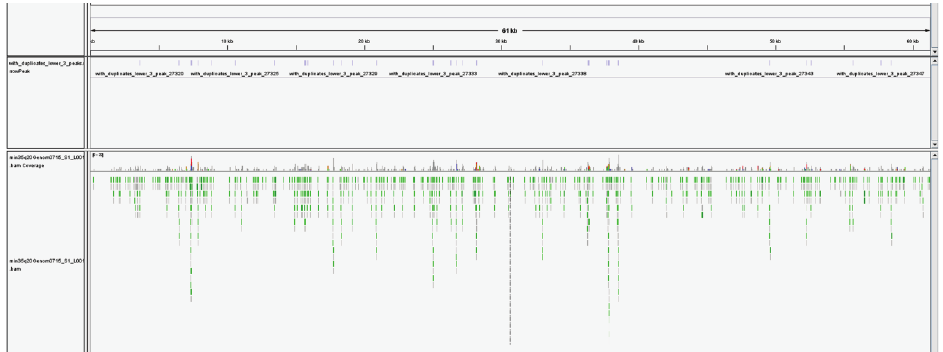
Figure 4. A representative region of the of assembled D. pulex genome contigs with mapped reads from one 5-hmC-enriched library (snapshot from IGV [42]). The upper lane shows detected peaks. The lower lanes shows individual reads along with coverage map.